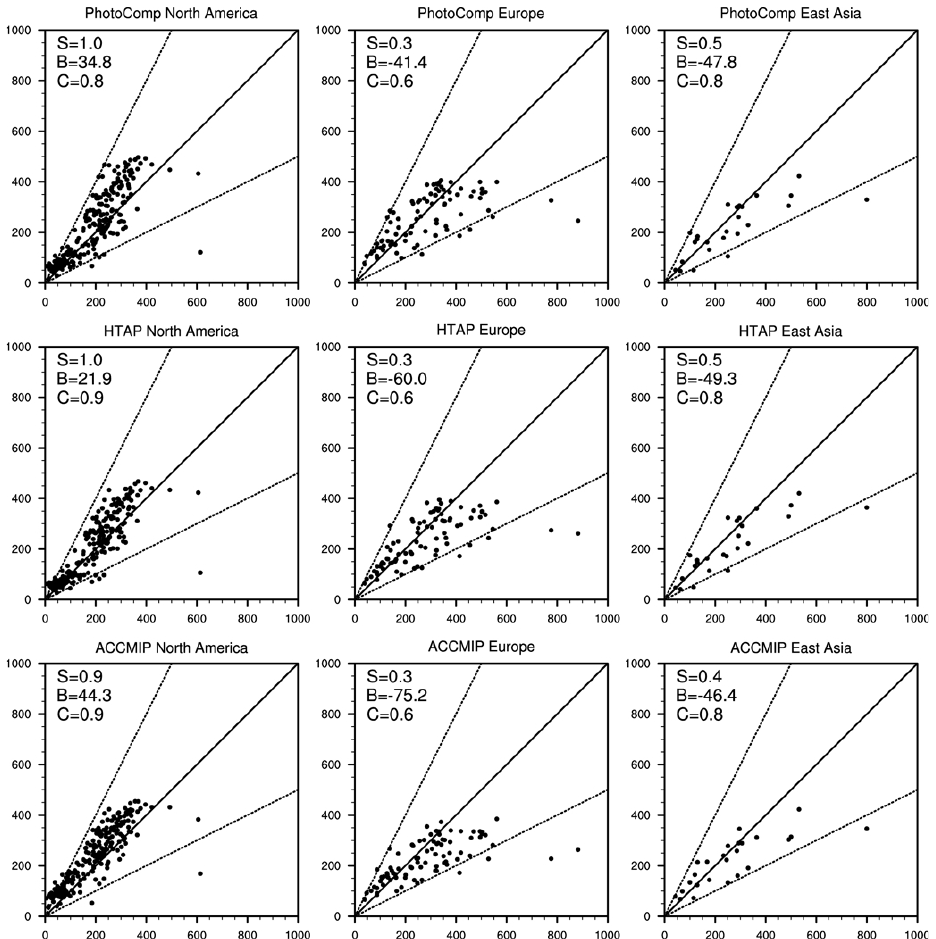
Fig. 2a. Scatter plot ( x axis: observations, y axis: multi-model mean) of nitrate wet deposition (mg(N)m − 2 yr − 1 ) over North America (left column), Europe (middle column) and East Asia (right column). Top row shows the model results from PhotoComp, middle row from HTAP and bottom row from this study. See text for details. S = slope, B = mean bias (mg(N)m − 2 yr − 1 ), and C = correlation (see Table